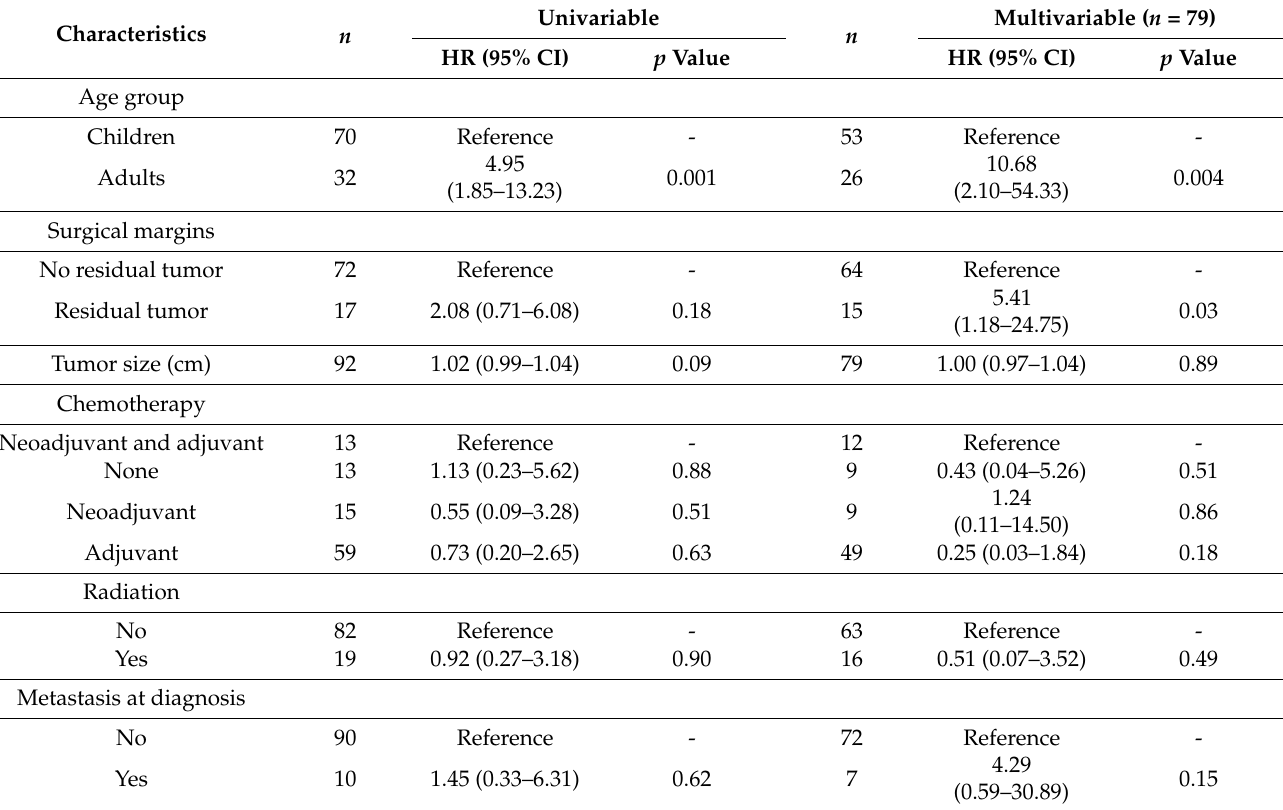
Table 3. Risk factors associated with mortality in surgically-treated